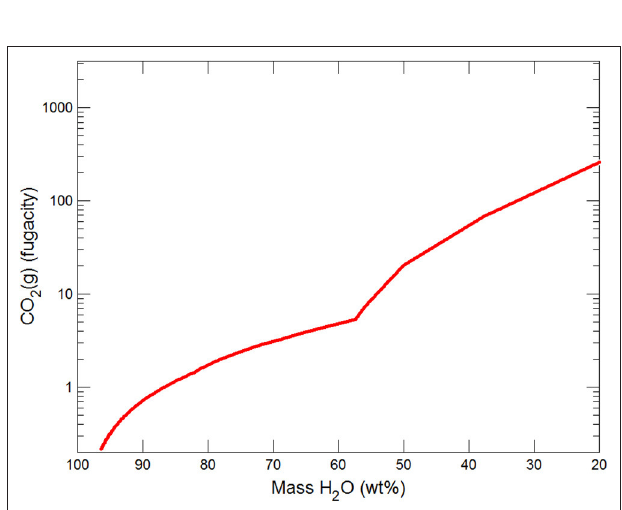
FIGURE 10 | Variations in Fe species during freezing of